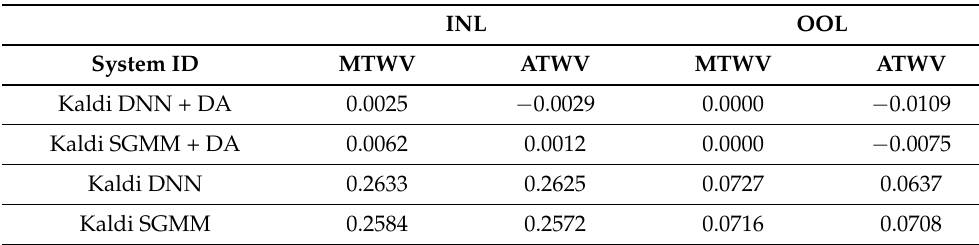
Table 19. System results of the STD task for RTVE test data for in-language (INL) and out-of-language (OOL) queries.